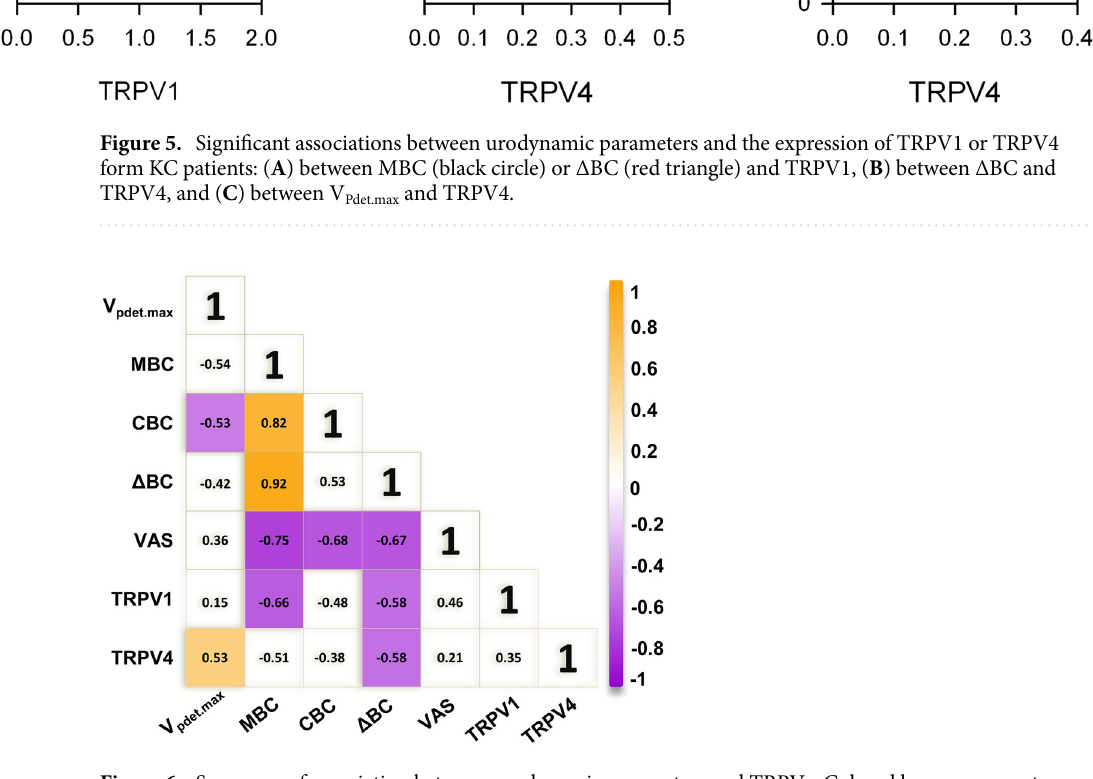
Figure 6. Summary of association between urodynamic parameters and TRPVs. Colored boxes represent a significant association coefficient between the variables ( P < 0.05). Chrome yellow and purple indicate positive and negative associations,